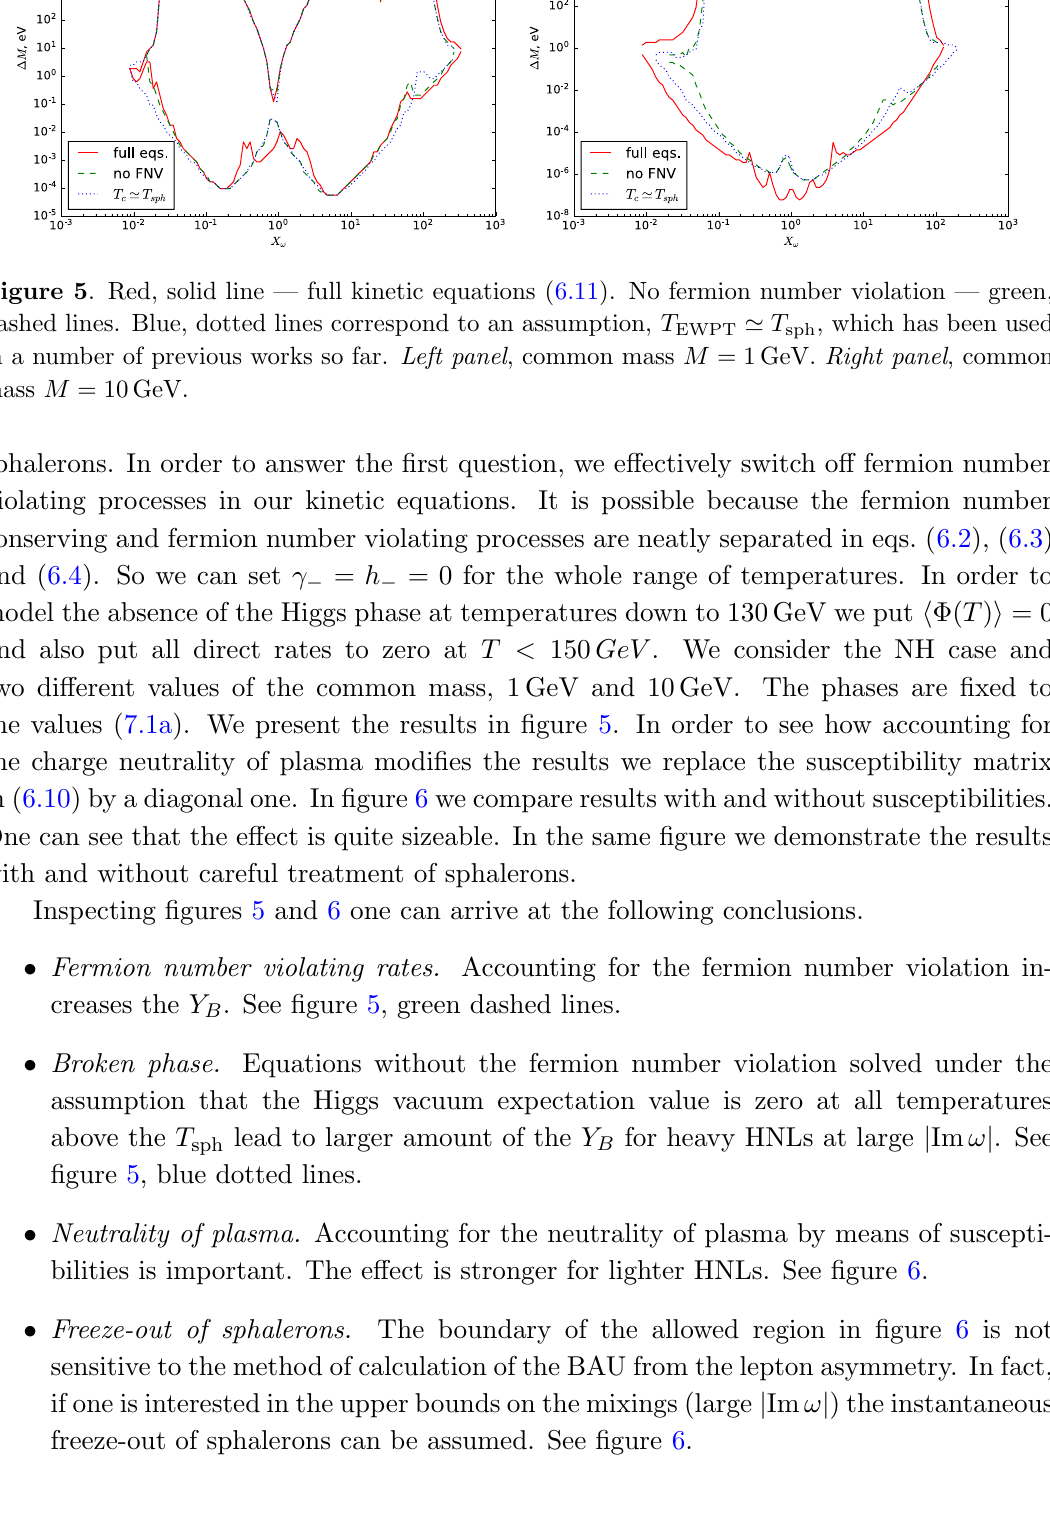
T sph , which has been used (cid:31)